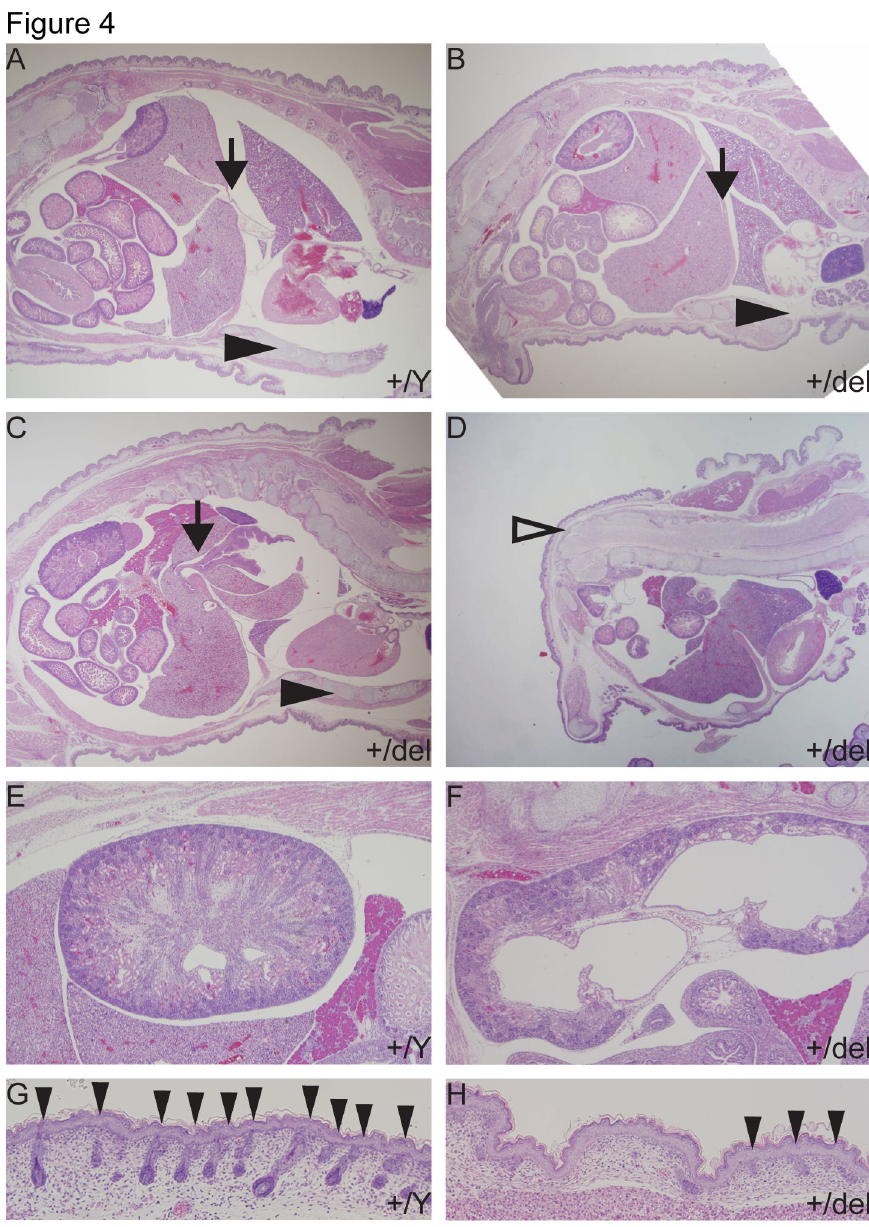
Figure 4. Histological analysis of Porcn +/del females at E18.5. At E18.5, in contrast to control Porcn +/Y littermates (A), several Porcn +/del females exhibited body wall closure defects (B, n=5/9), diaphragmatic hernias (C, n=5/9), and signs of spina bifida (D, open arrowhead, n=1/9). Arrows indicate the diaphragm. Arrowheads indicate the anterior body wall. Approximately 45% (n=4/9) heterozygous females displayed signs of severe kidney disease, such as hydronephrosis (F), which was not observed in control littermates (E). The skin of the majority of Porcn +/del fetuses (H, n=6/9) displayed signs of focal dermal hypoplasia as evidenced by reduction/absence of adnexa (arrowheads) (G,H). doi: 10.1371/journal.pone.0079139.g004 in ciliogenesis or lack ciliated cells in the affected tissues due as well as some mouse models of motile cilia dysfunction [31]. to differentiation defects remains to be tested. While individually variable, this spectrum of lesions suggests defects in cilia function. Whether Porcn mutants exhibit defects